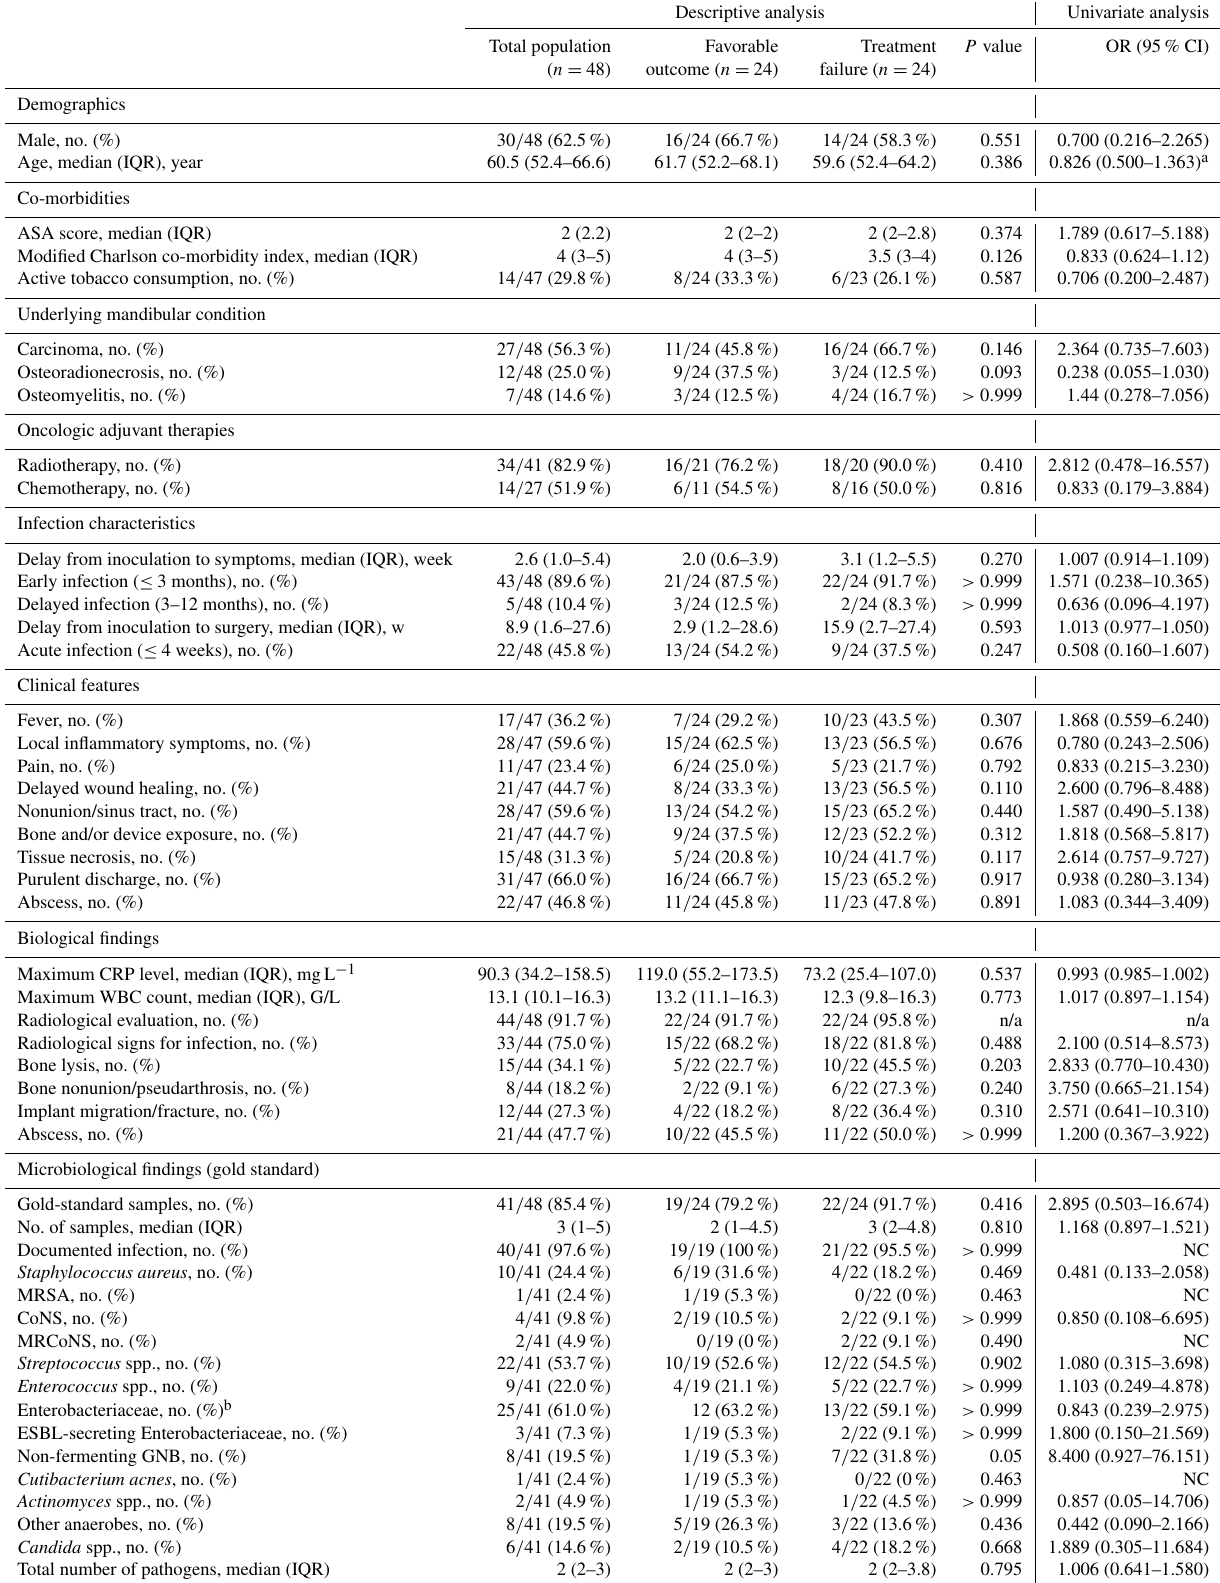
Table 1. Description of the included population and comparison of patients with favorable outcome or treatment